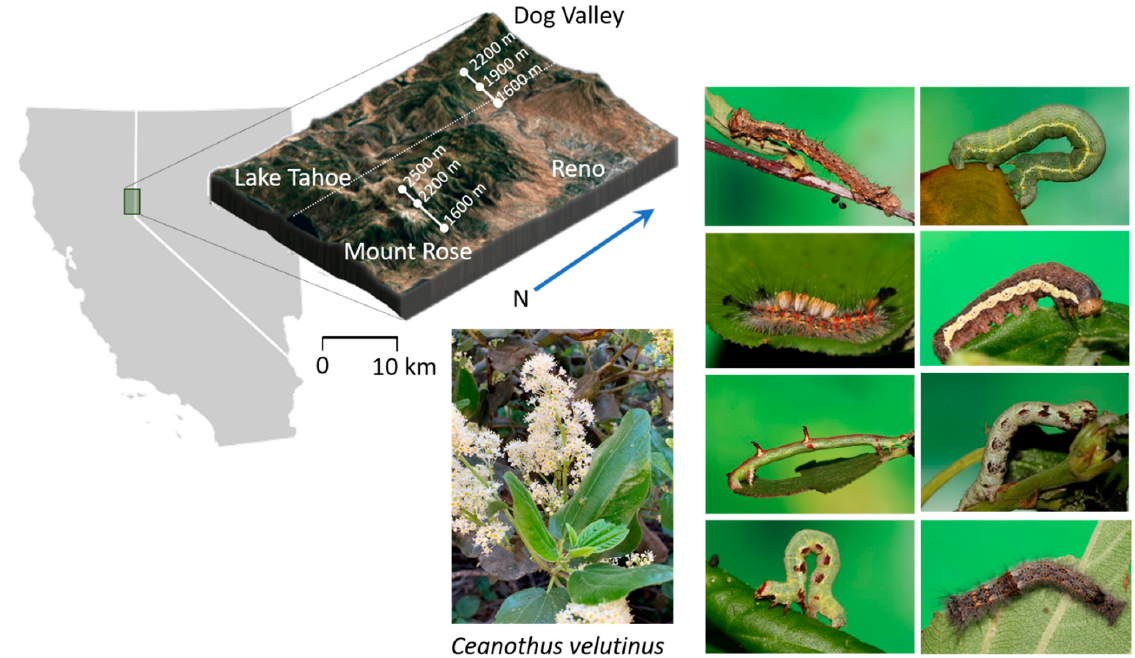
Figure 1. Collection site locations in the eastern Sierra Nevada, host species, and representative herbivores. 3D surface map in- cludes 10 km scale for reference.